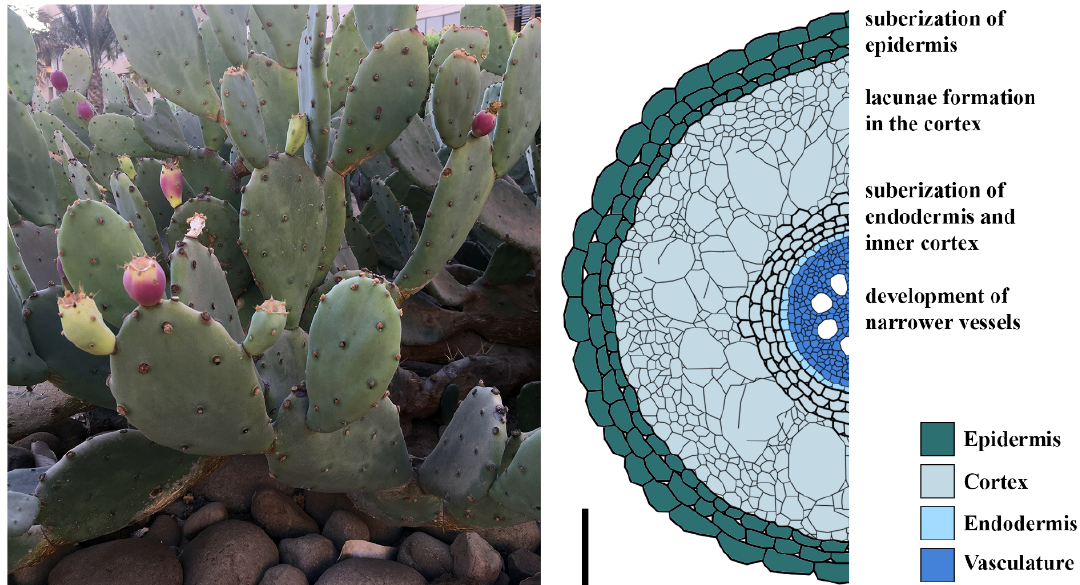
Figure 3. Left: Opuntia Ficus indica (prickly pear) in the King Abdullah University of Sciences and Technology (KAUST), Thuwal, Saudi Arabia. Right: schematic representation of a cactus rain root (cross-section); thick cell walls in the epidermis, inner cortex and endodermis indicate suberization; root scheme adapted according to [50,51,55]; scale bar 100 μm.